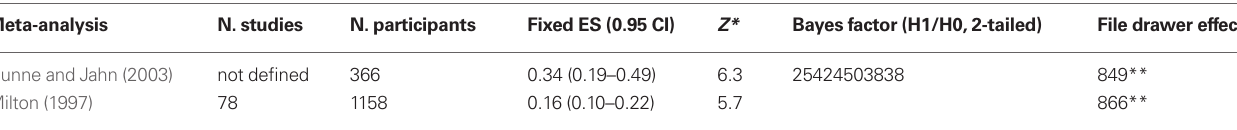
Table 2 | Results of the two meta-analysis related to remote